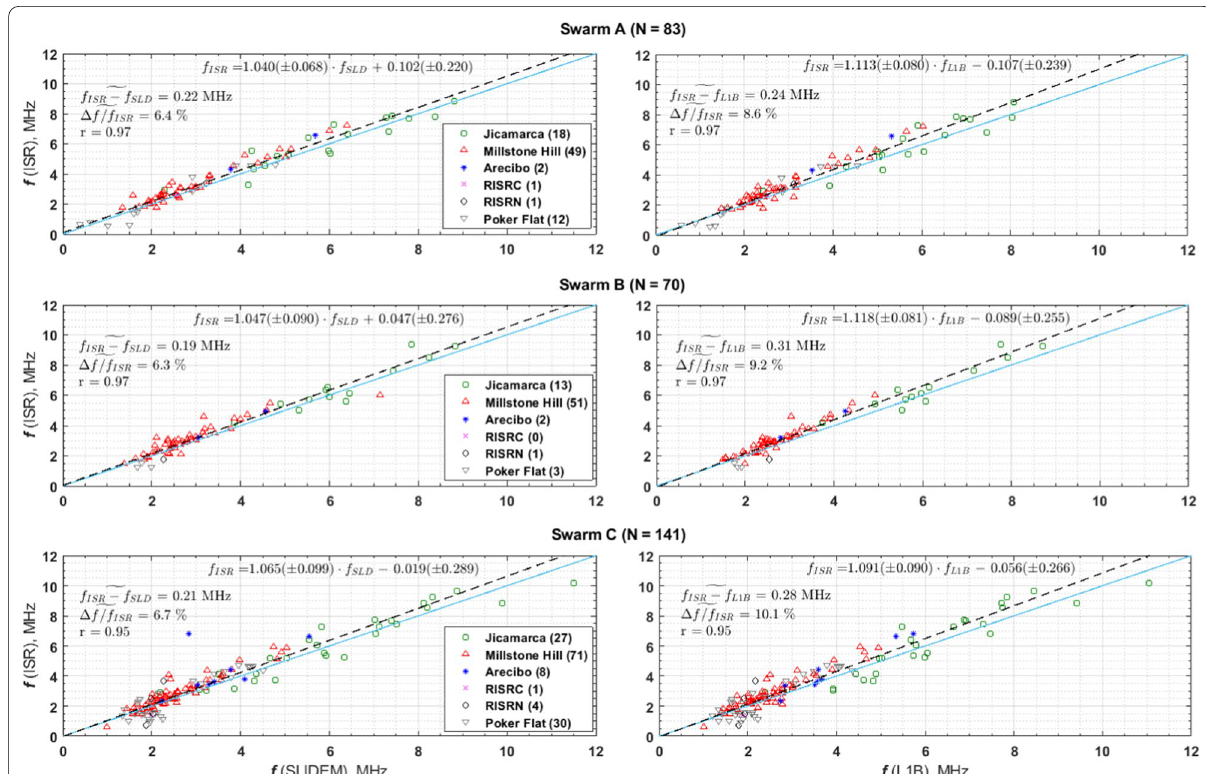
Fig. 1 ISR-Swarm conjunctions for Swarm A (top), Swarm B (middle) and Swarm C (bottom) panels. SLIDEM is on the left; L1b is on the right. The dashed black lines denote orthogonal-least-squares regression fits to the data, while the solid cyan line denotes a theoretical ‘ideal’ one-to-one correspondence. Both x - and y -axes are in units of MHz (plasma frequency) rather than density, following Lomidze et al. (2018) and references therein. The errors are given as standard errors at 95%